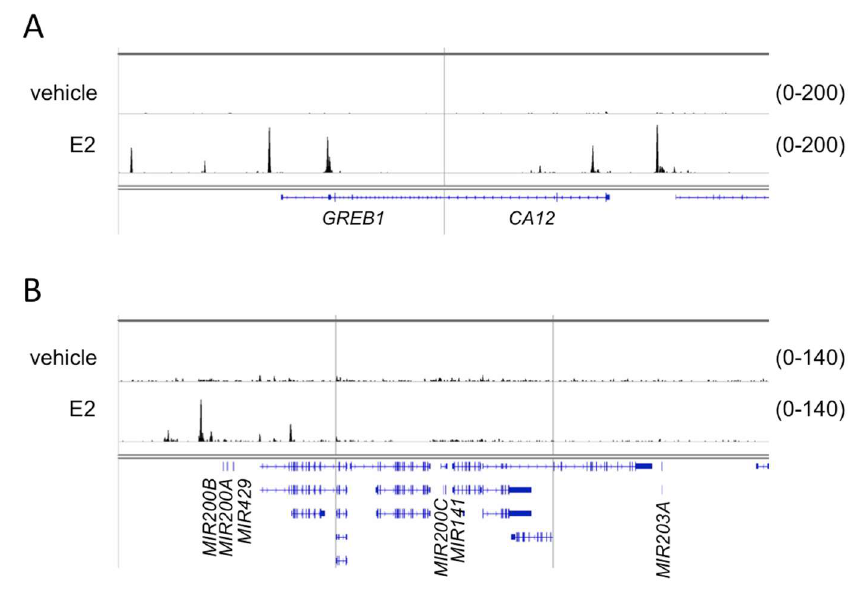
Figure 7. The genome browser view of ER α binding in case of the GREB1 , CA12 , miR200b-miR200a- miR429, miR200c-miR141 and miR203a genomic regions. ER α binding was determined in response to E2 treatment and in non-treated (vehicle) endometrial Ischikawa cells. ( A ) A 40 kb window around the transcription start site of two highly induced direct ER target genes, GREB1 and CA12 . ( B ) A 40 kb window around miRNA-encoding loci. For the sake of simplicity, gene symbols relevant to this study are indicated only on both panels.